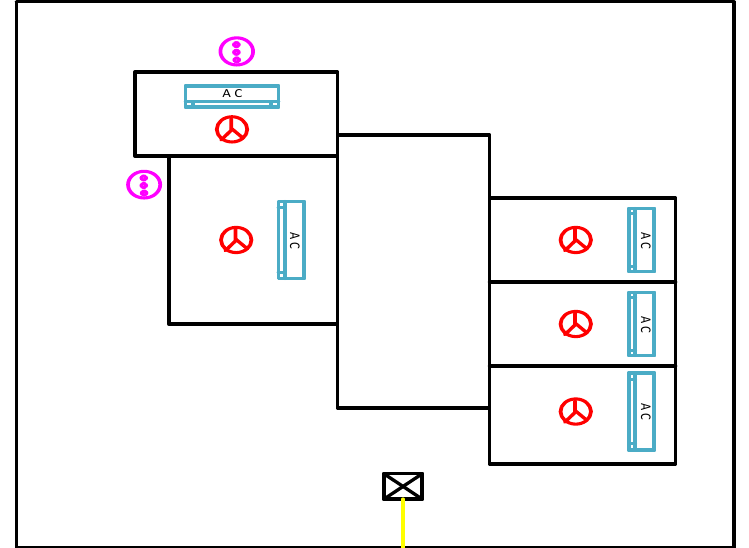
Figure 15. Coordinator house